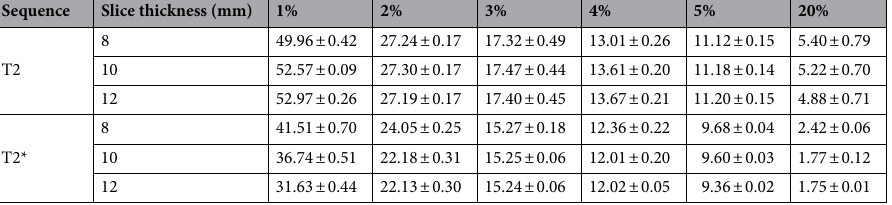
Table 3. Phantom mean measurements ± standard deviation of different slice thickness for T2 and T2*.